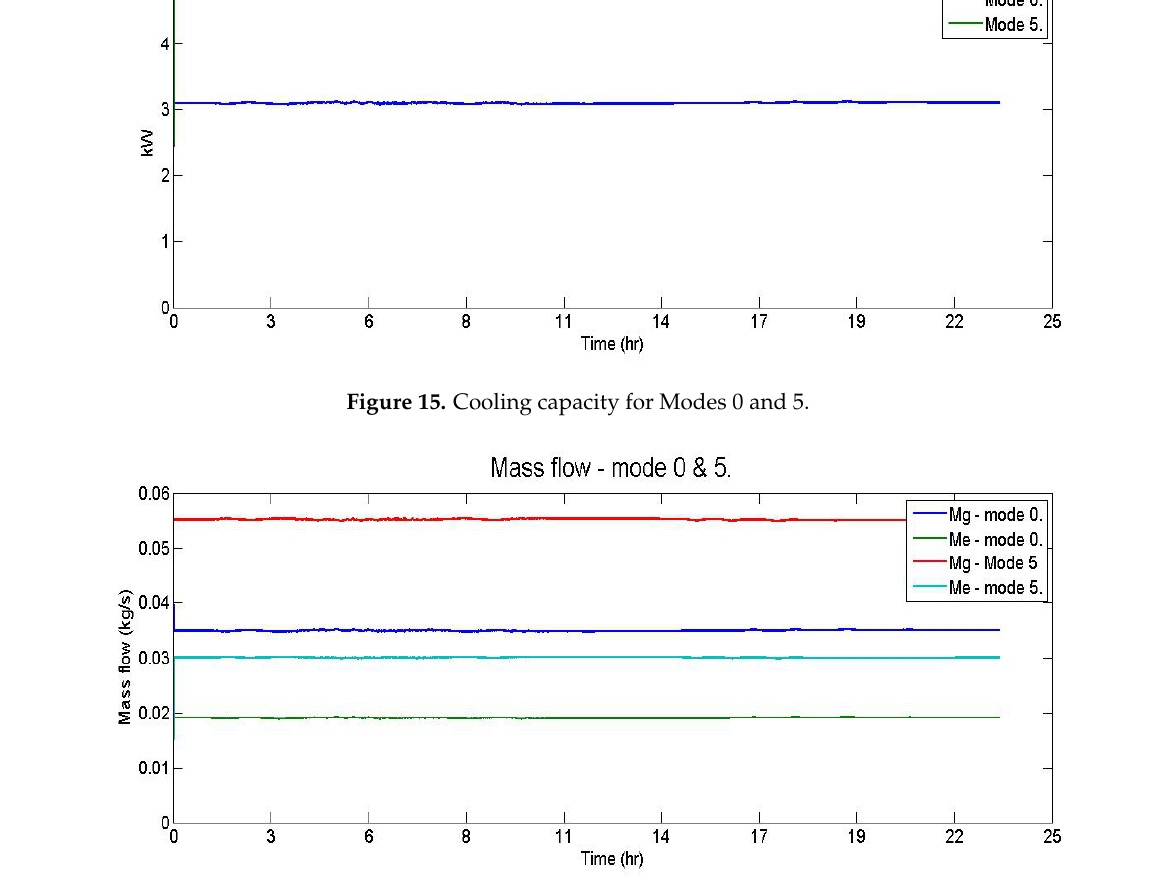
Figure 16. Mass flow of the generator and evaporator in Modes 0 and